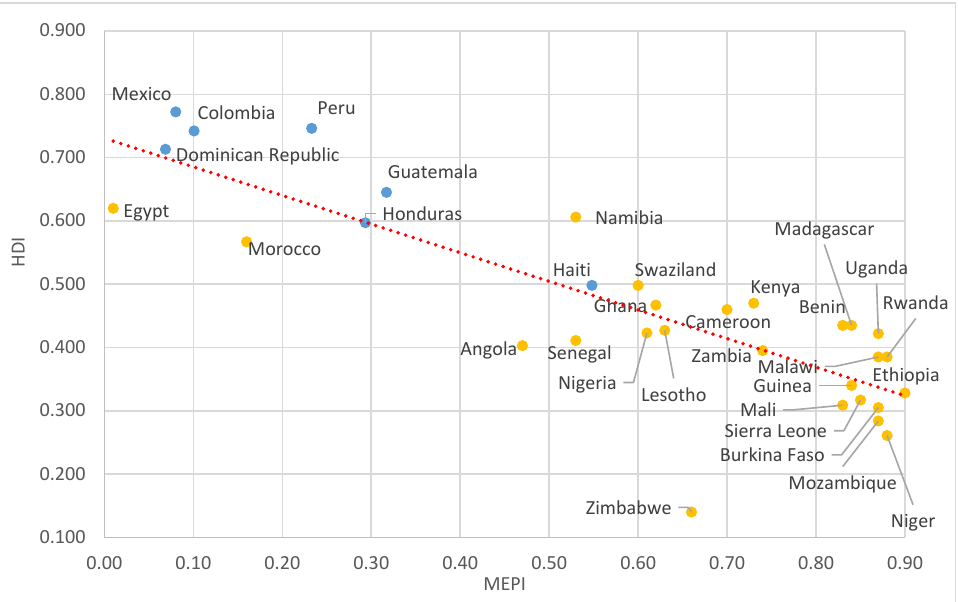
Figure 4. Relation between the MEPI and the HDI for both the Latin American countries (blue circles) and the African countries that Nussbaumer et al. (2012) analyzed (orange circles). Determination coefficient (r 2 ) equals to 0.71.